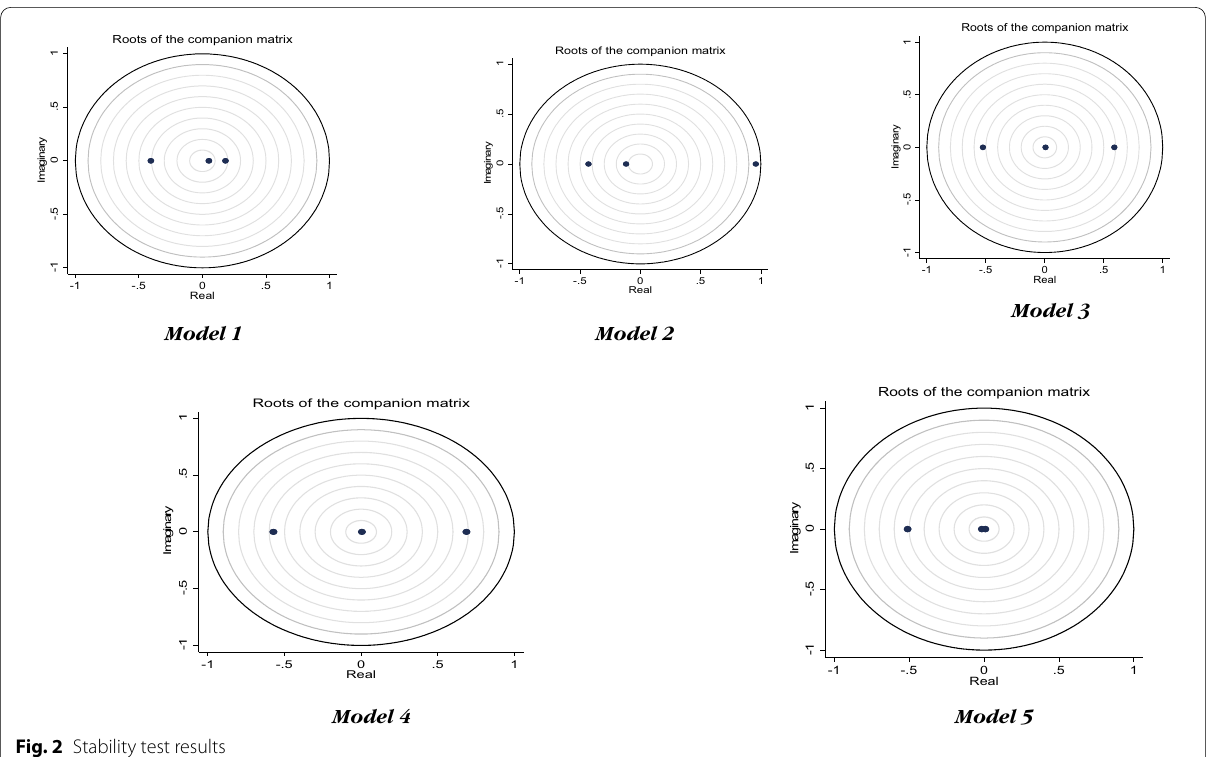
Fig. 2 Stability test